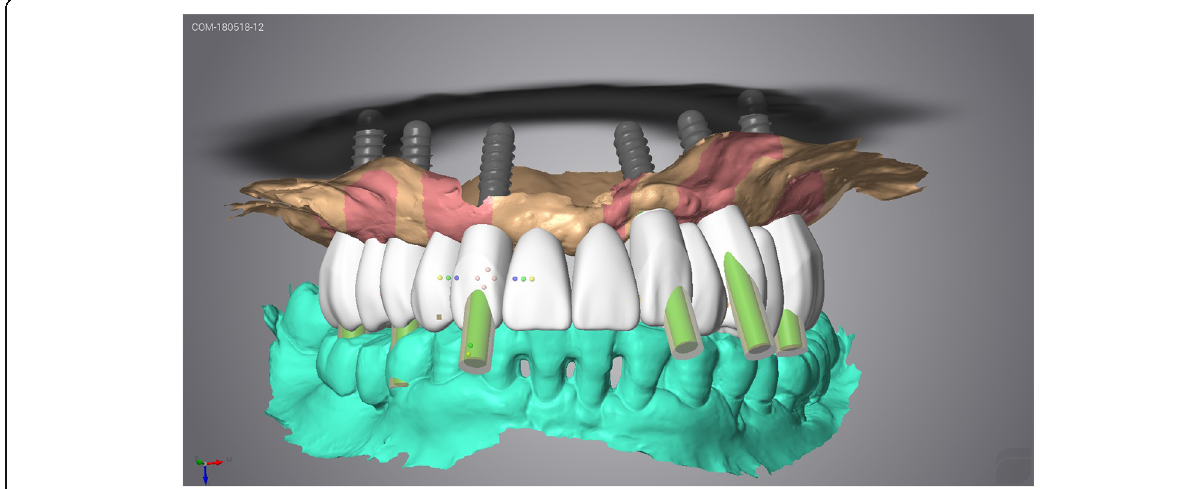
Fig. 14 Final restoration designed in CAD